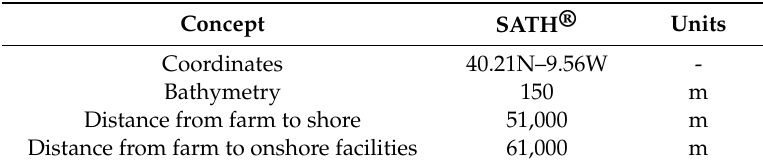
Table 2. Location of the SATH ® platform